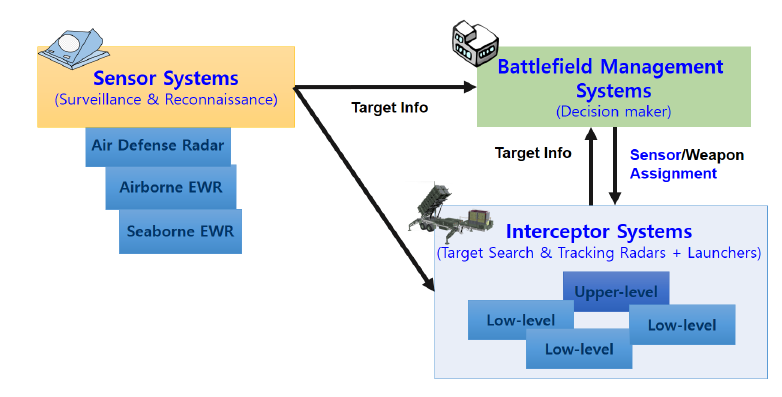
Figure 1. Schematic of system related to scheduling